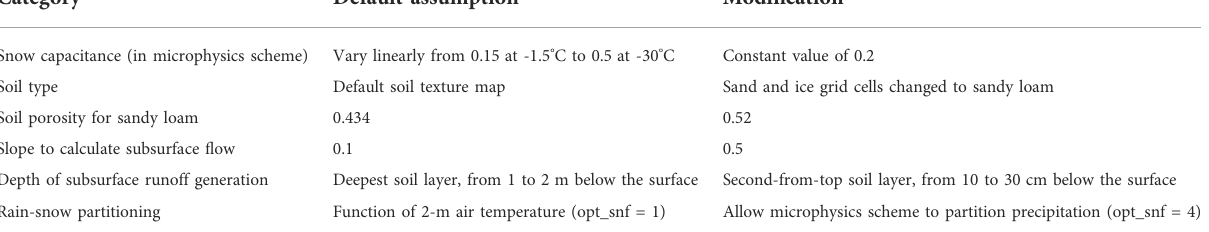
TABLE 2 Noah-MP modi fi